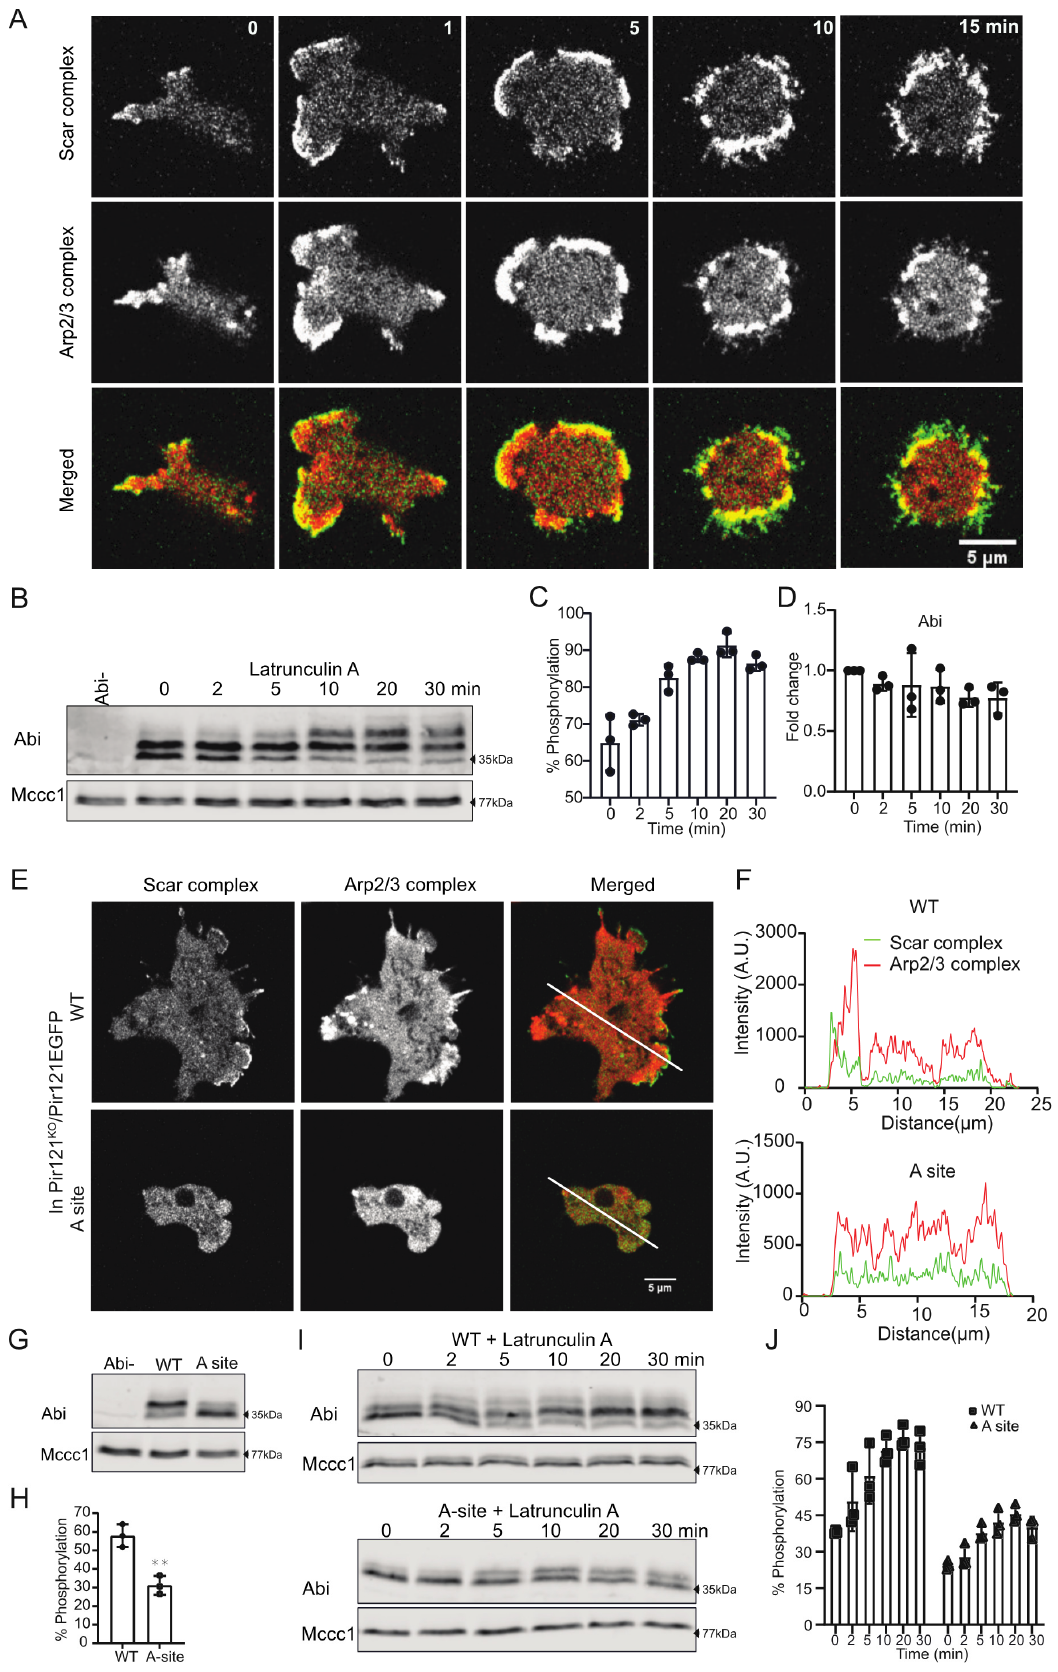
Figure 4. Effect of the activation of the Scar/WAVE complex on Abi phosphorylation. ( A ) Hyperactivation and